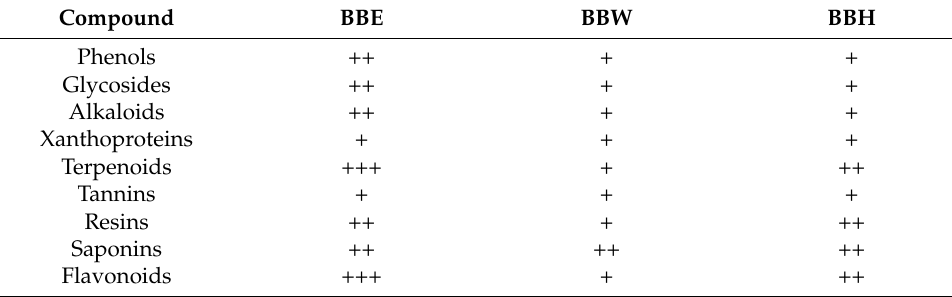
Table 1. Phytochemical screening analysis of BBE, BBW and BBH